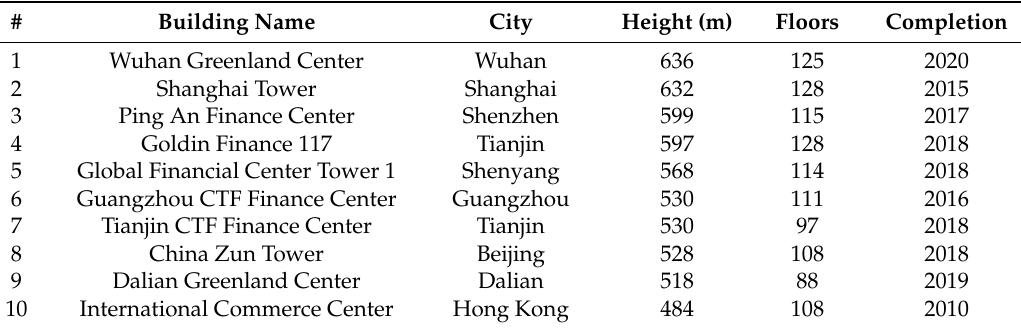
Table 6. Asia’s 10 tallest skyscrapers in 2020.